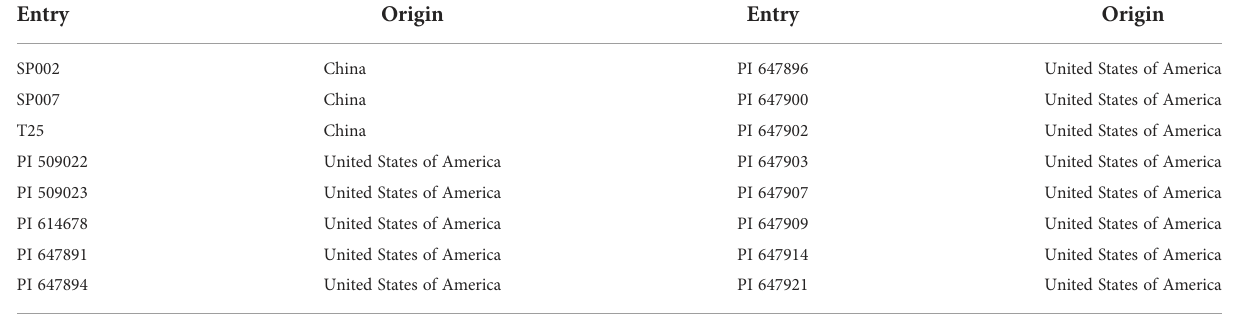
TABLE 1 The sources of 16 seashore paspalum